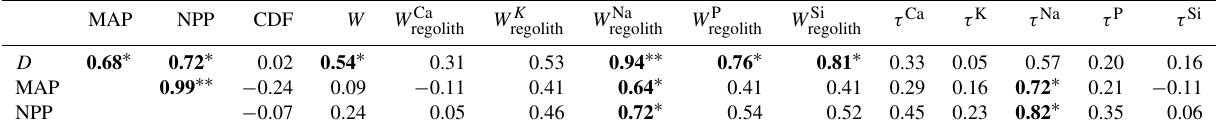
Table A5. Correlation matrix with Pearson’s correlation coefficients and significance ( ∗∗ : p< 0 . 01; ∗ : p< 0 . 05) for net primary productivity (NPP), denudation rate ( D ), mean annual precipitation (MAP), and indices of total and elemental degree and rate of weathering. Correlation coefficients involve the study sites Pan de Azúcar, Santa Gracia, and Nahuelbuta. Here we treat each regolith profile as independent, i.e., n = 6. La Campana has been excluded because it features the steepest relief of all sites, which causes elevated denudation rates. Bold numbers denote significant correlation.